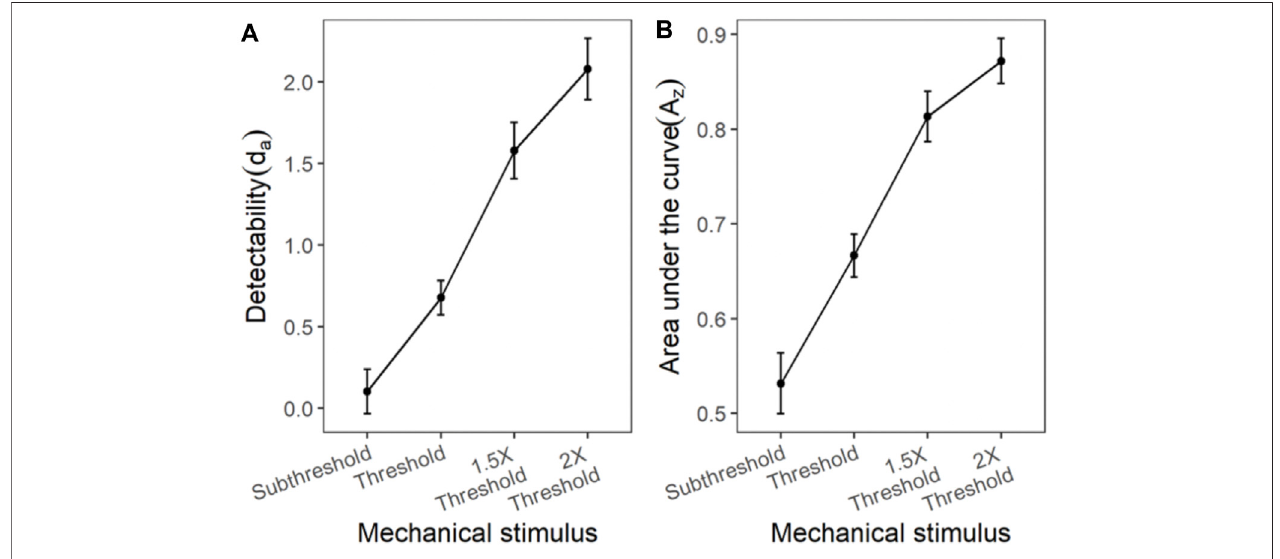
FIGURE9| Thetransducerfunctionford a andA z ofmechanicalstimuli.Eachhorizontalaxisisstimulusintensityandintheleft-handpanel,the y -axisisdetectability (d a ) and in the right-hand panel, the y -axis is area under the curve (A z ). The points are the means and error bars are the SE of the estimates.